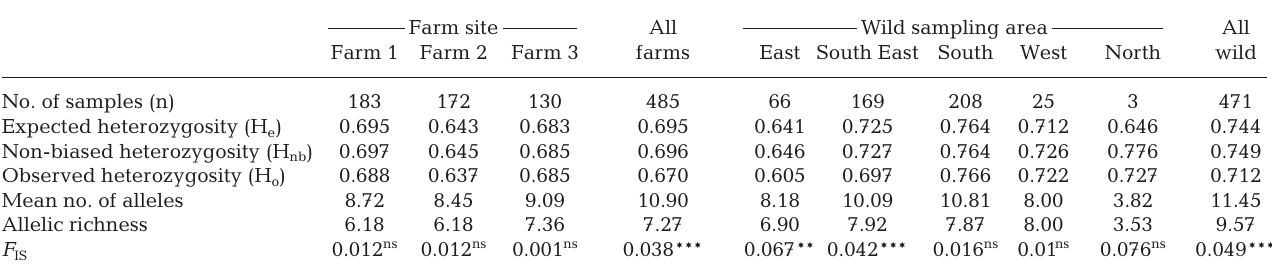
using the analysis of molecular variation (AMOVA) procedure in GENALEX. Table 2. Population statistics for farmed and wild fish, with breakdowns by each farm and each wild fish sampling area, based on 11 microsatellite loci (ns: not significant, **p < 0.01, ***p < 0.001). Allelic richness is based on 25 samples except for the North area which is based on 3